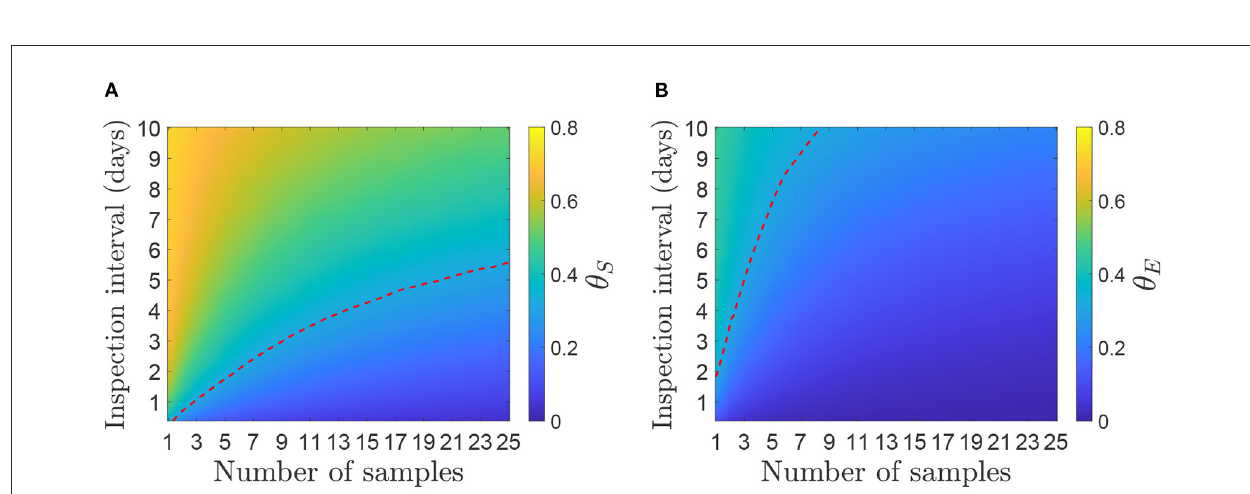
FIGURE4 Mean proportion of infectiousness before detection for a herd size of 50 cattle. (A) Infectiousness is measured as the sum of viral shedding ( θ S ). (B) Infectiousness is measured as the sum of environmental contamination ( θ E ). The red dotted line represents the level of θ required for R h = 1 if each measure of infectiousness was the only route of between-herd